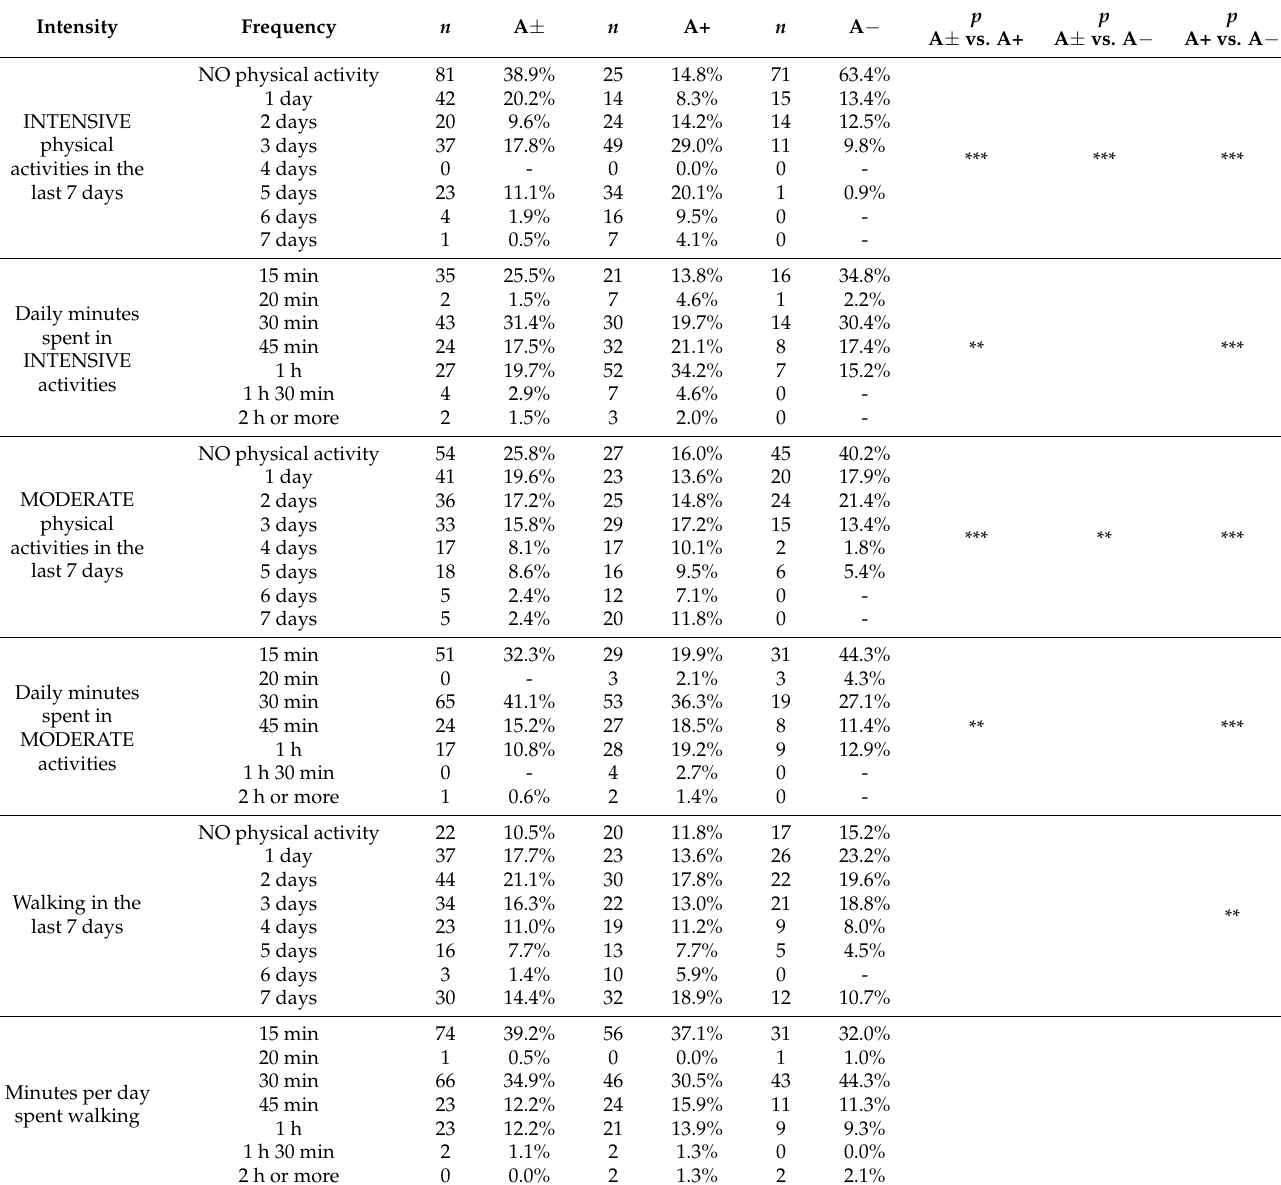
Table 3. Groups according to questions in the IPAQ